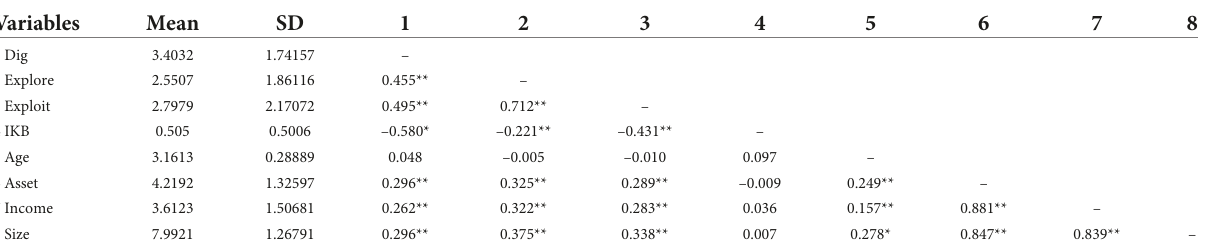
TABLE 3 Descriptive statistics and correlations matrix ( N =